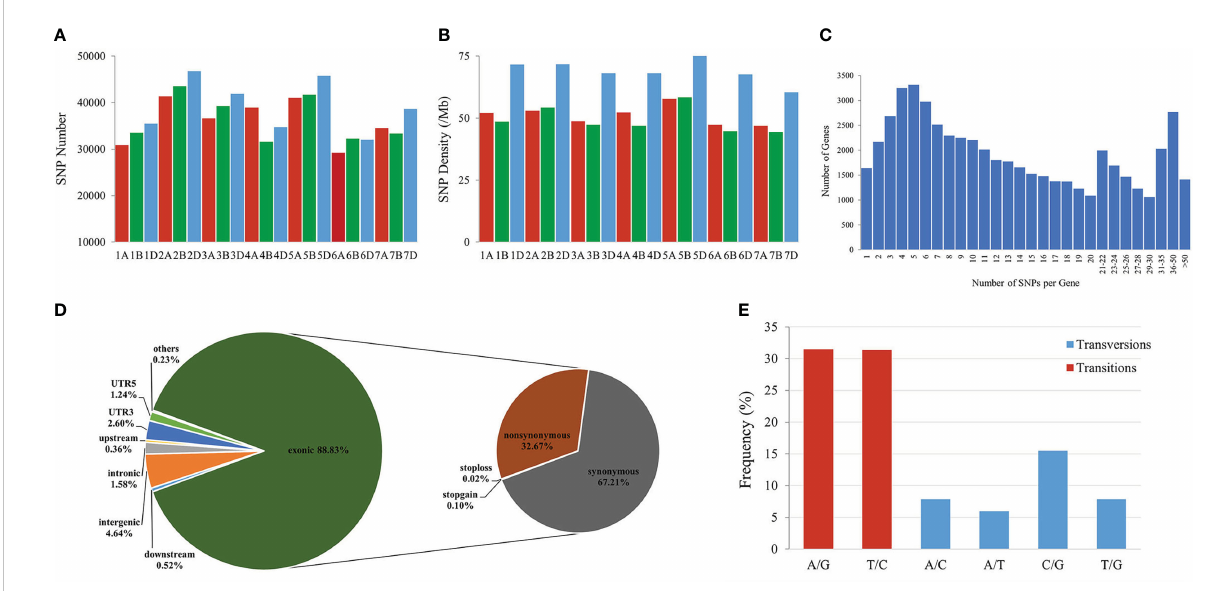
FIGURE 5 Features of SNPs between P. huashanica and wheat. (A) Distribution of SNPs in the wheat chromosomes. (B) Density distribution of SNPs in the wheat chromosomes. (C) Distribution of the number of SNPs per gene. (D) Distribution of SNPs in different genomic regions. (E) Frequency of different substitution types in the identi fi ed